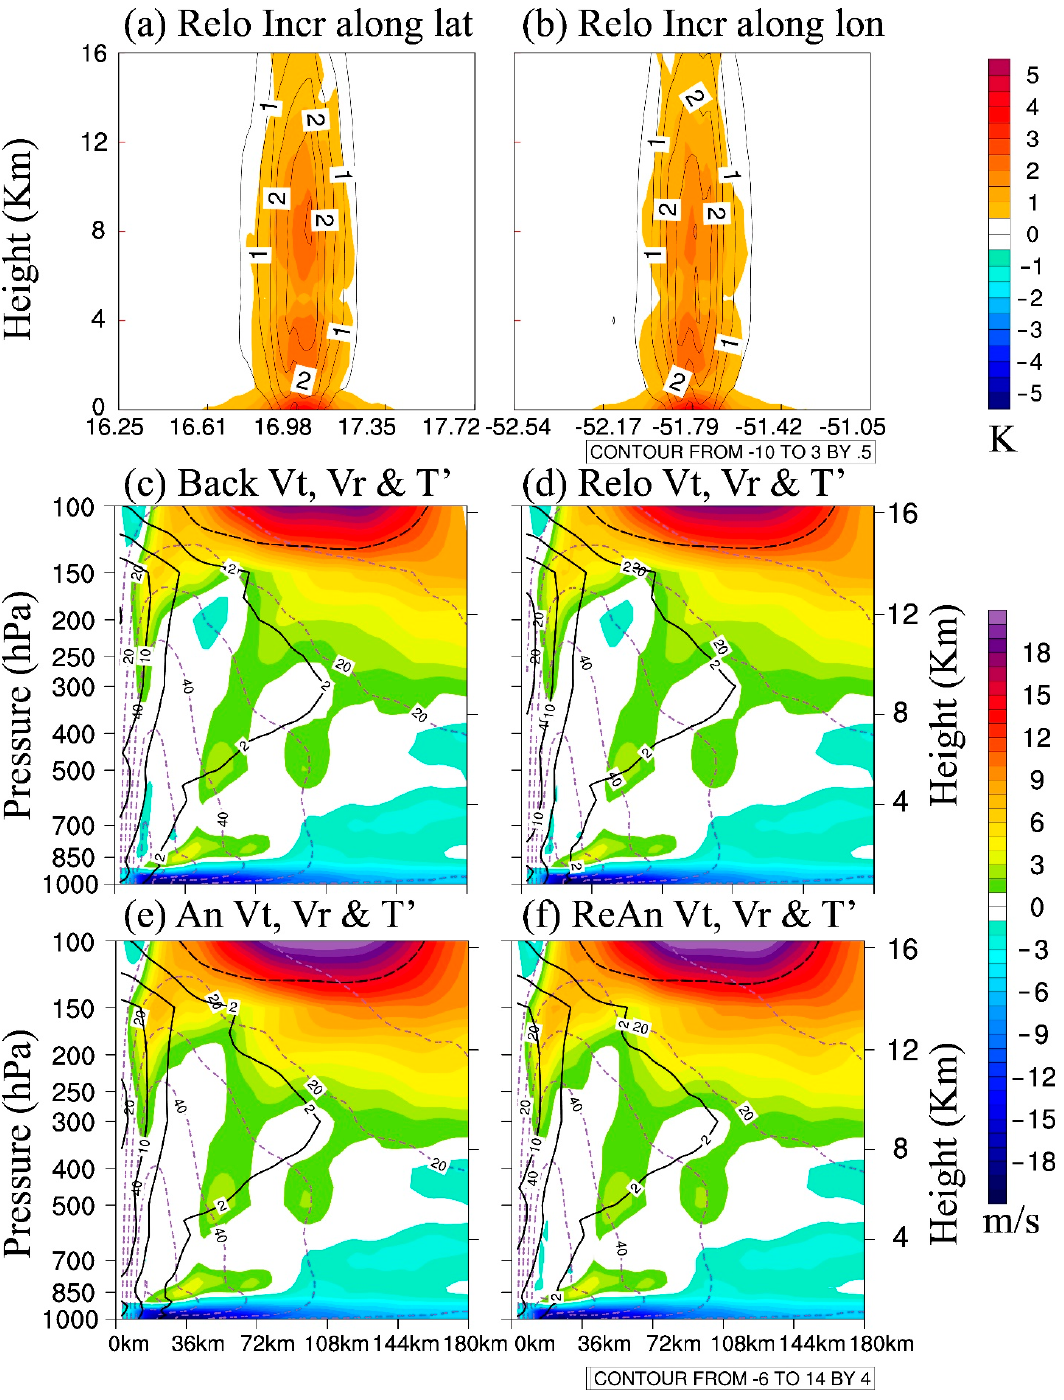
Figure 10. Temperature increment (shading) and pressure increment (contour) from VR for the ( a ) south-to-north and ( b ) west-to-east cross-sections valid at 07:00 UTC, 4 September 2017. ( c – f ) is the same as Figure 6, except for ( c ) Background storm, ( d ) VR storm, ( e ) DA analysis based on ( c ), and ( f ) DA analysis based on ( d ) valid at 07:00 UTC, 4 September 2017.